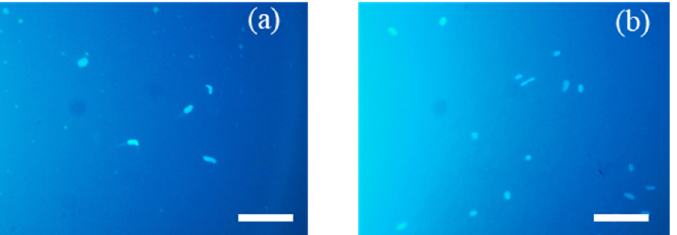
Figure 9. Microscopic image of adhered HeLa cells on the surface ( a ) before and ( b ) after the reaction with DMEDA. Scaling bars indicate 100 μ m.